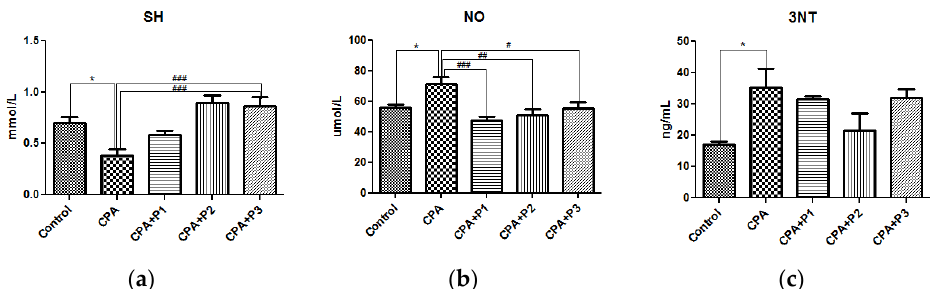
Figure 2. ( a ) The SH concentration, ( b ) NO and ( c ) 3NT levels in serum of Control, CPA and CPA + P1/P2/P3 exposed animals. Data represent mean ± SEM; One-way ANOVA followed by Bonferroni’s Multiple comparison test; * Significant at p < 0.05 — compared with Control group; # Significant at p < 0.05; ## Significant at p < 0.01; ### Significant at p < 0.001 — compared with CPA group.